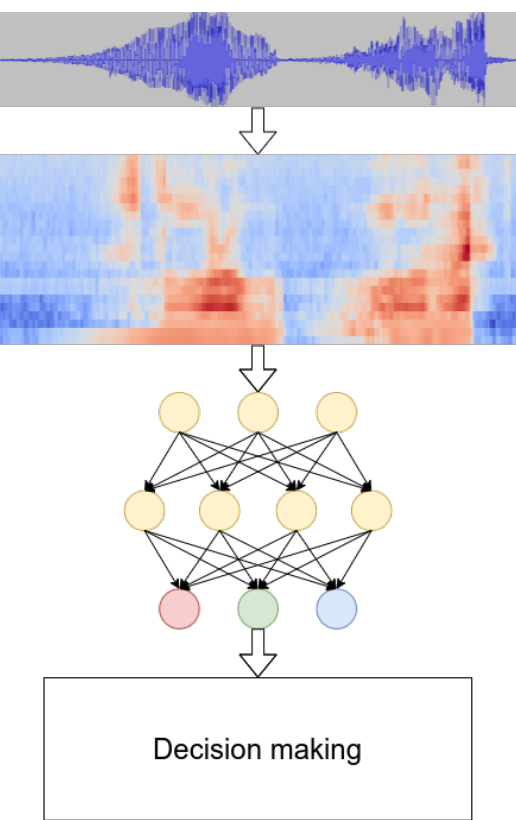
Figure 1. The scheme of a typical voice activation